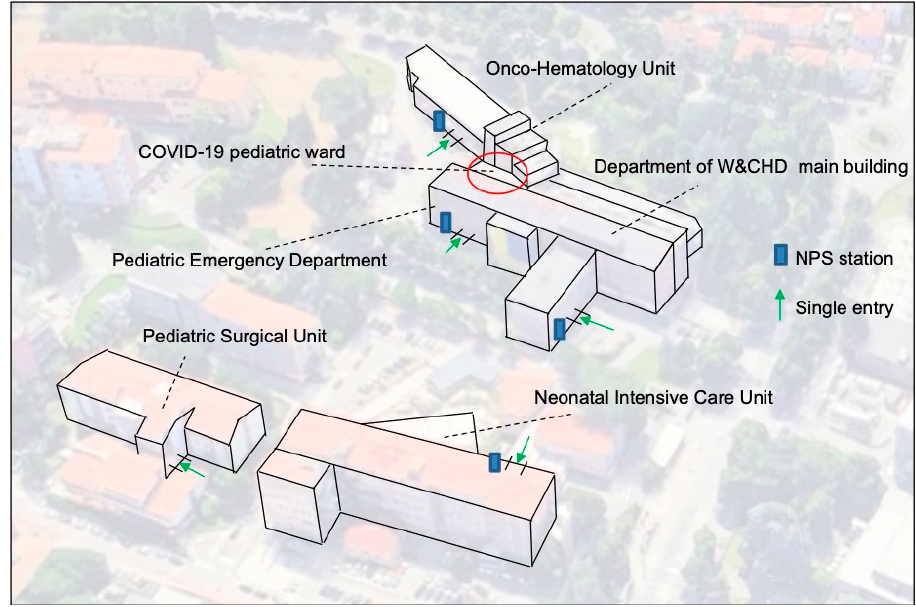
Figure 1. Distribution of clinical wards with their own single access and nasopharyngeal swab (NPS) station: a representative map.